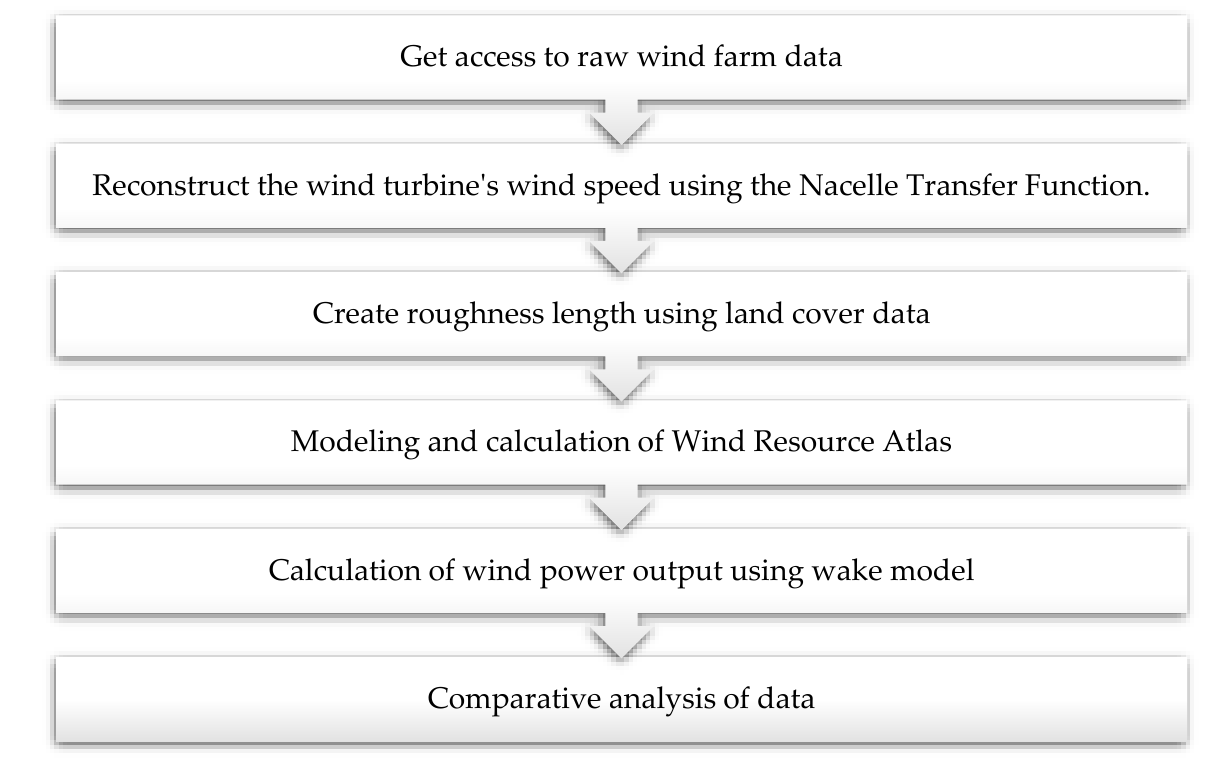
Figure 4. Verification flowchart.